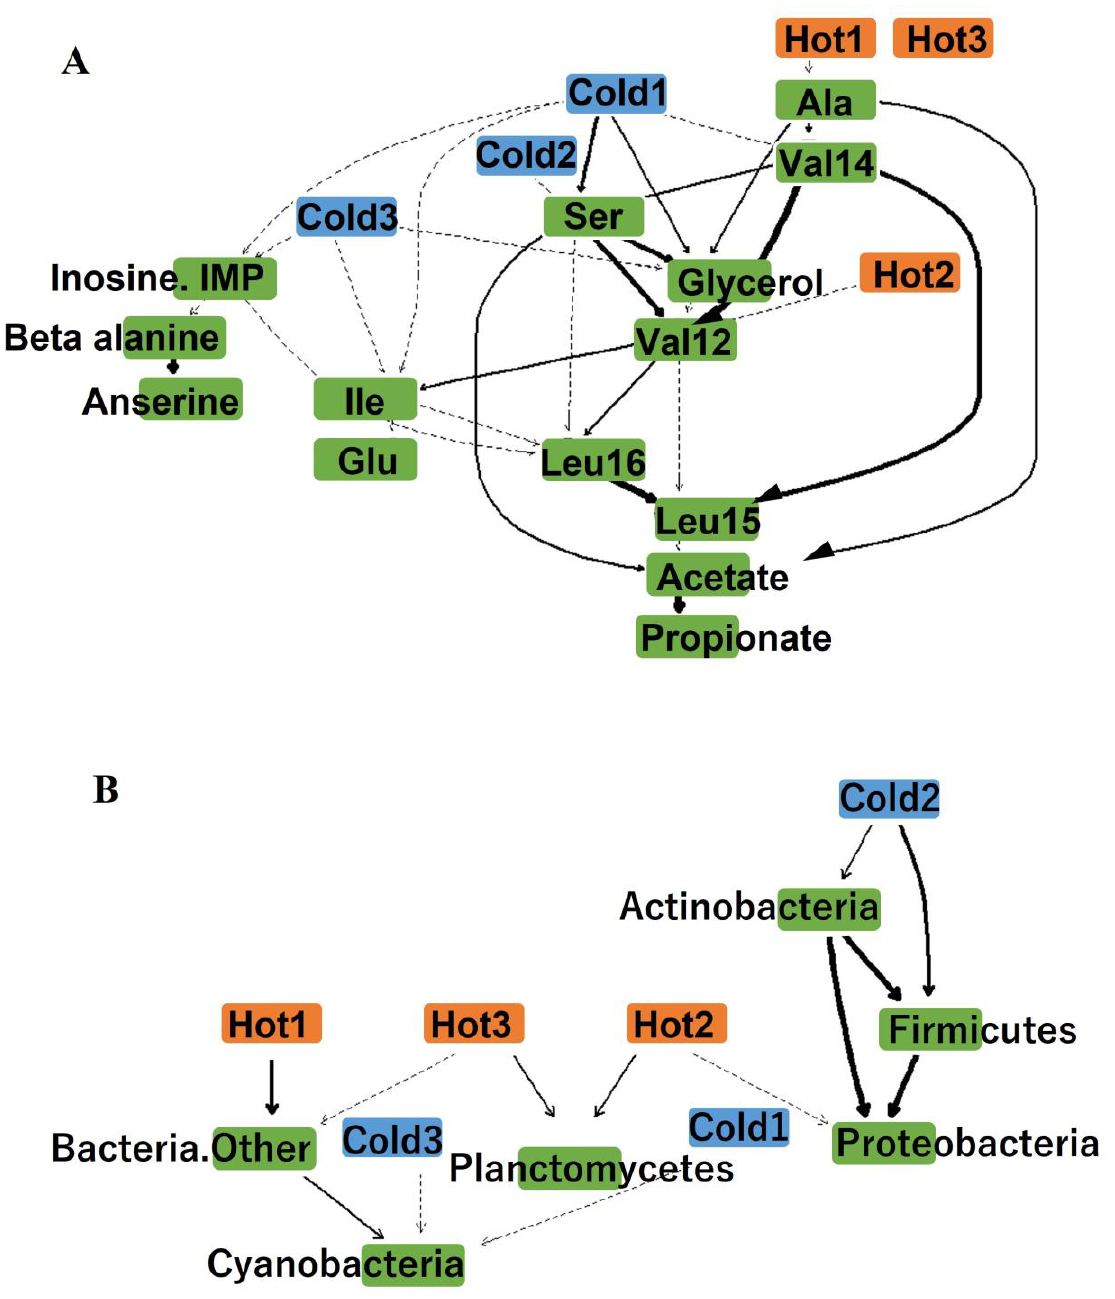
Figure 5. Network diagram of Bayesian network analysis of NMR and NGS data: ( A ) is a network calculated using NMR data; ( B ) is a network calculated using NGS data. Both diagrams were bootstrapped. Orange squares show hot water condition, and the number indicates elapsed months. On the other hand, blue squares show cold water condition, and the number indicates elapsed months. Green squares show metabolites (in ( A )) or the phylum of bacteria. The thickness of the arrow indicates the strength of the tie, and the thicker the arrow, the stronger it is. An arrow indicated by a dashed line represents a weak connection. The same metabolite with different number shows different peaks in NMR measurements.